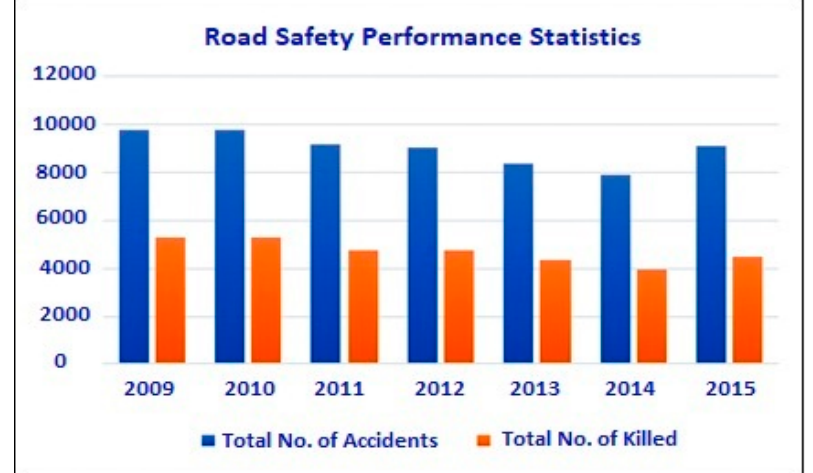
Figure 1. Road accident statistics of Pakistan (Source SBP [60]).